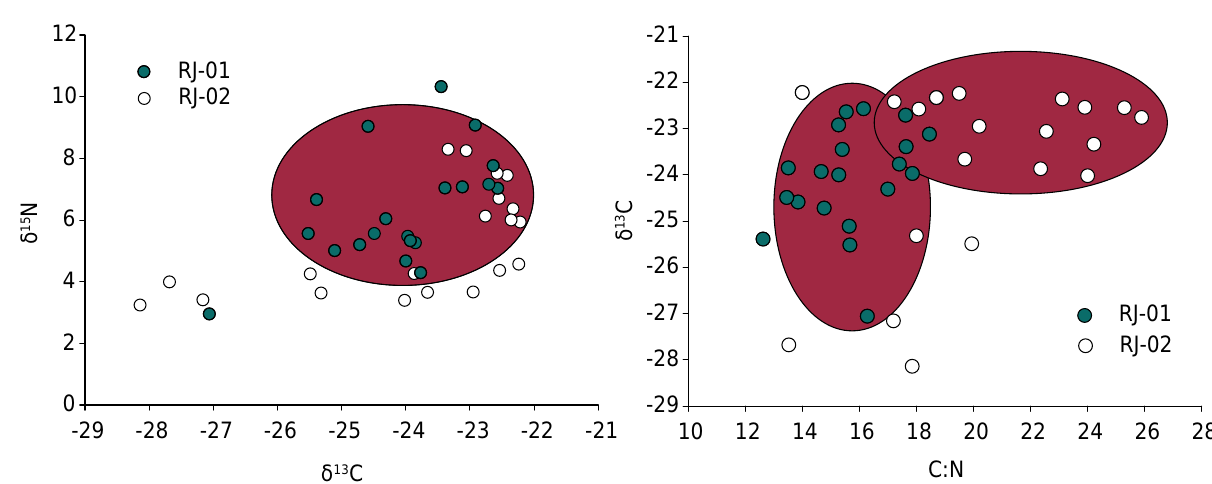
Figure 3. Relationships between δ 13 C and δ 15 N (left) and between δ 13 C and C:N (right) for Organossolos in the upper montane environment of Itatiaia National Park, Rio de Janeiro,